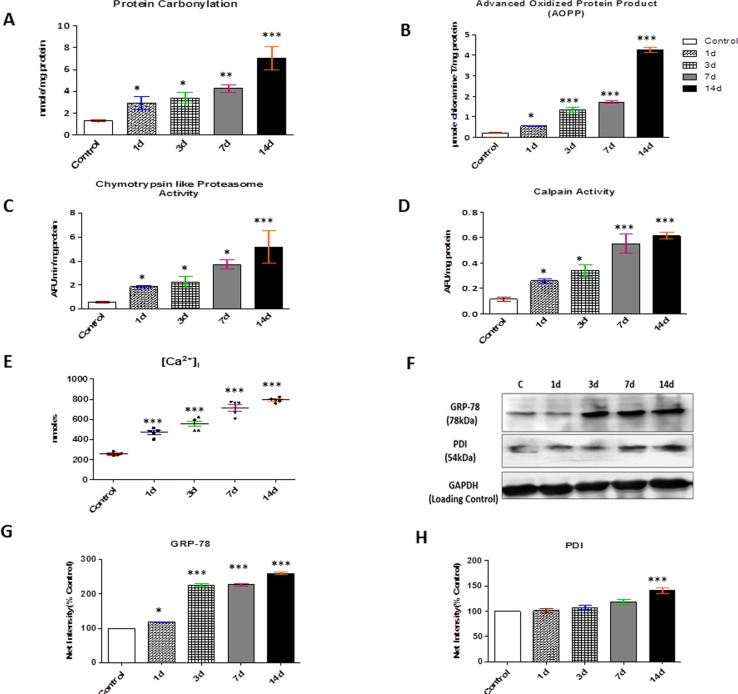
Presence of oxidized/misfolded proteins activates protein degradative pathways.(A) Protein Carbonylation (B) Advanced Oxidized protein product (AOPP) (C) Chymotrypsin-like 20 proteasome activity (D) Calpain activity (E) Intracellular Calcium ion (F) Representative western blots for expression of ER chaperones of skeletal muscle cytoplasmic extracts. (n = 3) and (G-H) Semiquantitative analysis of the expression of GRP-78 and PDI. GAPDH considered as the loading control. The densitometric analysis is shown as mean with standard error (bars) performed in n = 3 independent experiments. *p<0.05 Vs. Control; **p<0.01 Vs. Control; ***p<0.001 Vs. Control.